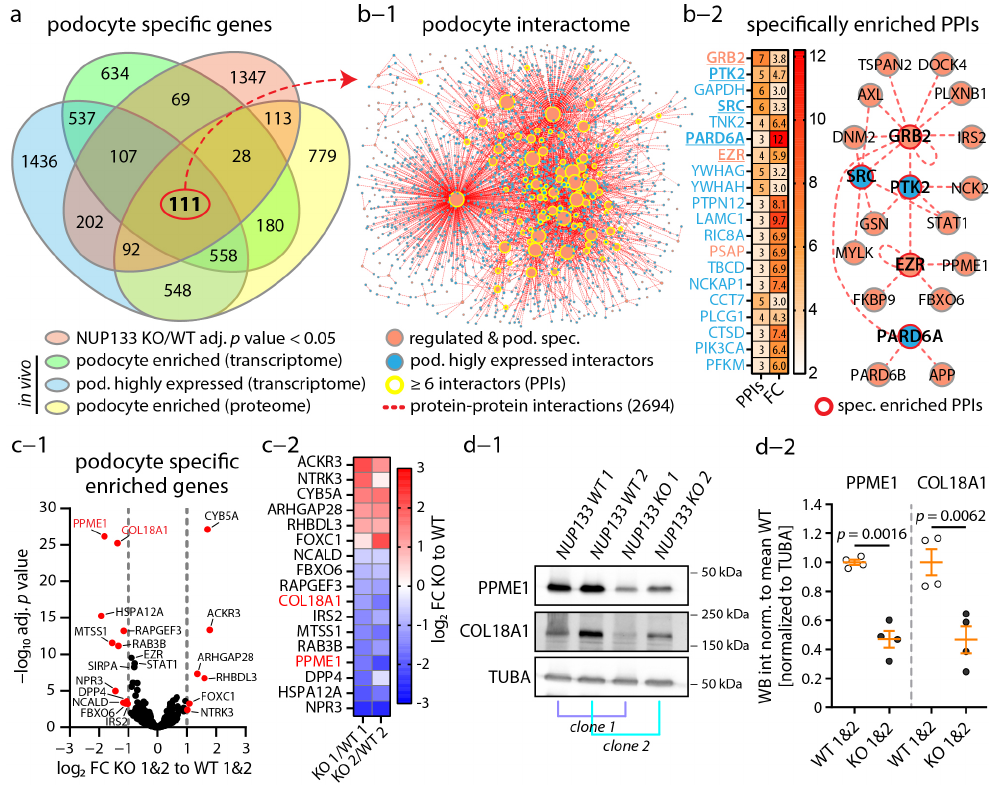
Figure 4. Loss of NUP133 disturbs the podocyte-specific transcriptome. ( a ) Venn diagram analysis of NUP133-dependent differentially expressed genes (adj. p -value < 0.05), and murine in vivo podocyte transcriptome- and proteome-based expression data reveals a highly podocyte-specific set of 111 genes that were altered by NUP133. ( b-1 ) Protein interaction network analysis for encoded proteins of these 111 genes suggests disruption of a large group of protein complexes expressed in podocytes in vivo. Network showing the altered podocyte interactome (nodes indicate proteins and dashed lines indicate protein–protein interactions (PPIs); node size indicates number of PPIs; NUP133 regulated genes (encoded proteins) and podocyte interactors are color-coded as indicated). ( b-2 ) Enrichment analysis for podocyte PPI partners revealed enrichment of an interconnected group of cytoskeletal regulators. Overrepresented PPI partners are presented as a heat map ( b-2 ), and a representative interaction network of these proteins is shown (nodes/proteins are color-coded as in graph ( b-1 ); the heat map is color-coded as indicated for PPI number and enrichment (FC— fold change)). ( c-1 ) Further analysis of in vivo podocyte-specific expressed genes, mapped by dif- ferential expression analysis of NUP133 WT and KO podocytes, identified PPME1 and COL18A1 as downregulated genes. Volcano plot shows NUP133-dependent regulation of in vivo podocyte-spe- cific enriched genes (red dots indicate NUP133-dependent regulated genes (log2 FC > (abs. ± 1) and